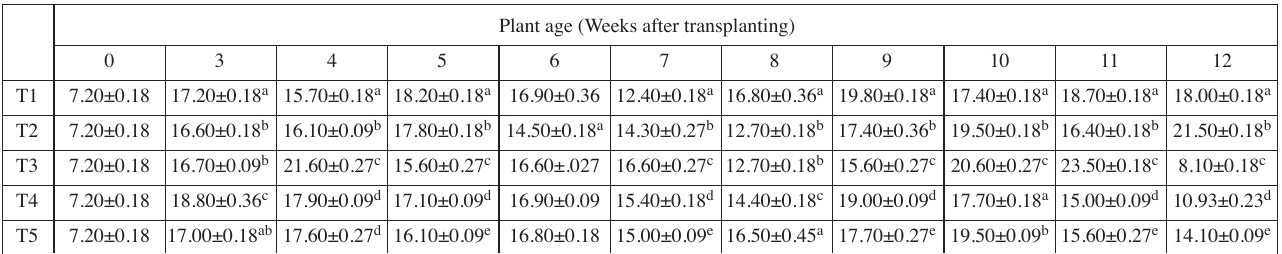
Tab. 2a: Effect of organic and inorganic fertilisers on Cu (mg/kg) of Solanum nigrum L. cultivated in the field